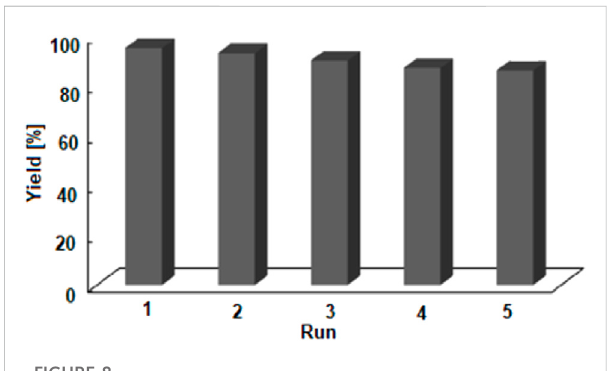
FIGURE 8 Recycling experiments of Cu-PTC@GO.